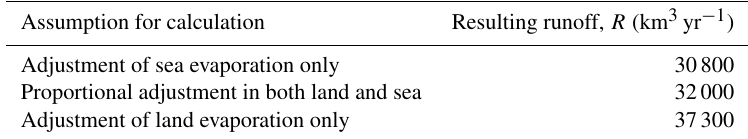
Table 6. Sensitivity analysis of water balance